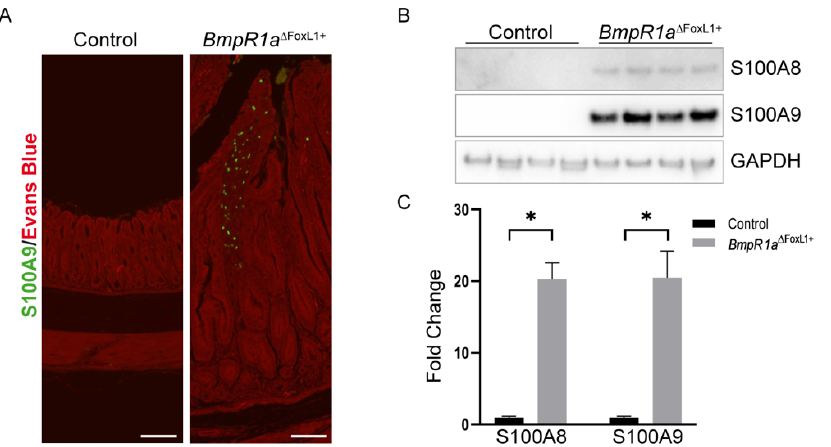
Figure 5. S100A8 and A9 proteins are upregulated secreted factors in BmpR1a △ FoxL1+ mice, indicating an inflammatory response. ( A ) Immunostaining against S100A9 (shown in green) revealed an increase in its expression in the mesenchyme-enriched area of the antrum tissue of BmpR1a △ FoxL1+ mice compared to that in controls. ( B ) Immunoblot analysis of the total antrum tissue indicates strong expression of both S100A8 and S100A9 proteins in BmpR1a △ FoxL1+ mice compared to that in controls. ( C ) Quantification of immunoblots confirmed a significant increase in both S100A8 and S100A9 in the mutant animals (FC = 20.34 and 20.48, respectively) compared to that in controls. Statistical analysis was assessed using the Mann–Whitney test with * p < 0.05. Evans blue was used as a counterstain (red signal in ( A )). Scale bar = 100 µm.